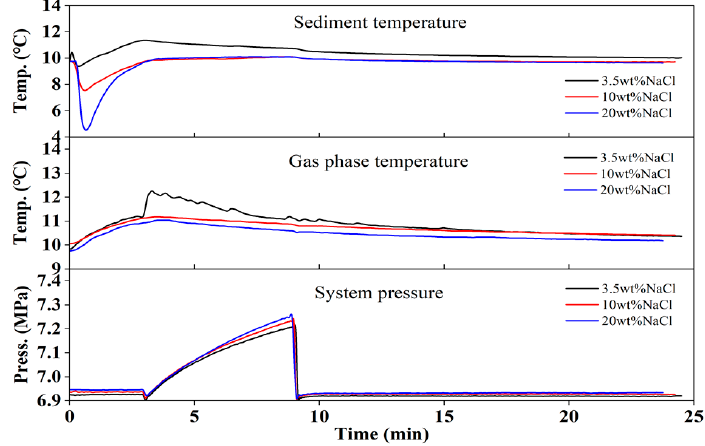
Figure 6. Temperature and pressure changes under different salinity in the sediments at 9 ◦ C and 6.9 MPa with 30% hydrate saturation.